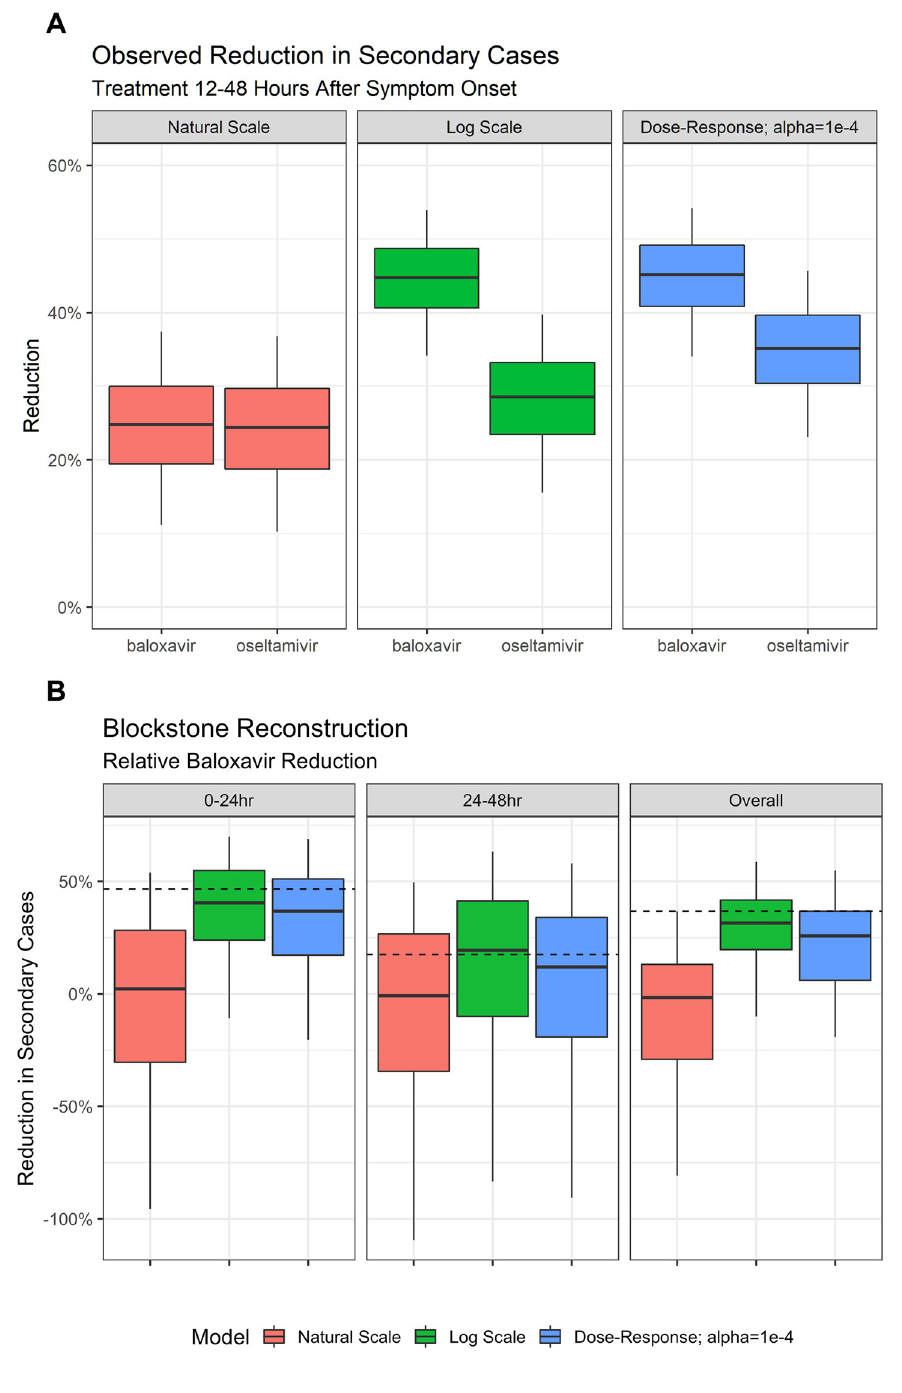
Fig 5. Estimated reduction in secondary cases of influenza with baloxavir and oseltamivir. The boxplots show median, interquartile range, and 95% confidence intervals. (A) Estimated reduction in secondary case rate among household contacts with prophylactic baloxavir and oseltamivir according to natural-scale, log-scale, and dose– response models, assuming treatment within 12–48 hours of symptom onset in the index case. Variability across individuals is shown. (B) Relative reduction in secondary cases with baloxavir treatment, comparing simulations with observed clinical trial data. Data are shown for baloxavir treatment at 0–24 and 24–48 hours after symptom onset in the index case, as well as overall (irrespective of treatment initiation time). The dashed line indicates data from